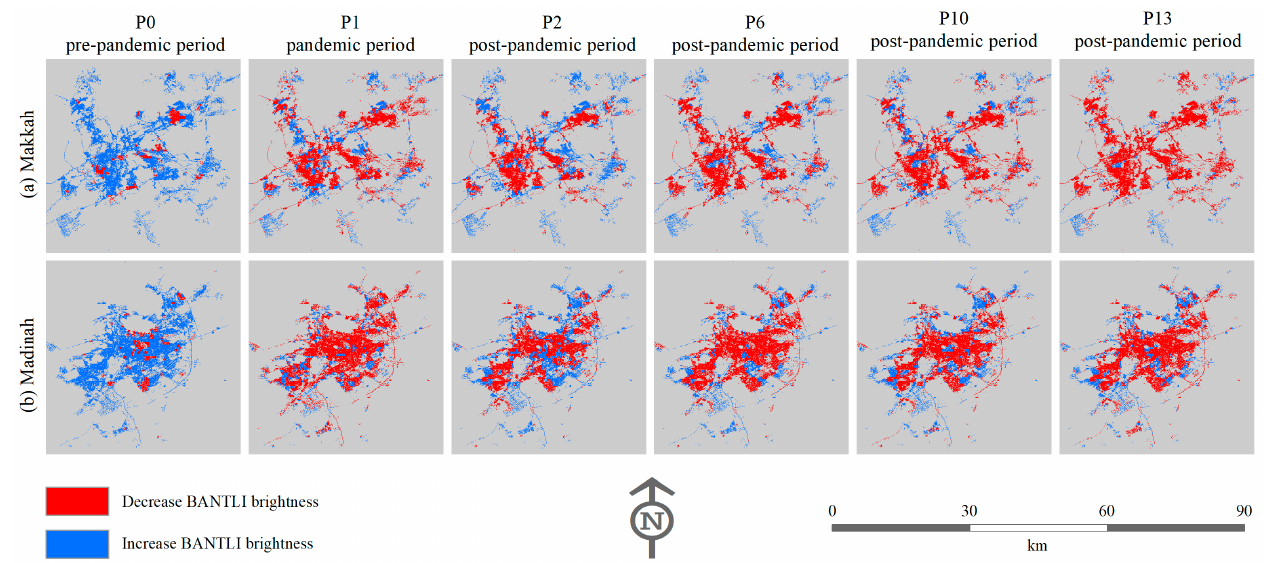
Figure 15. Spatial changes of the BANTLI brightness in ( a ) Makkah and ( b ) Madinah at the pixel level during selected periods.